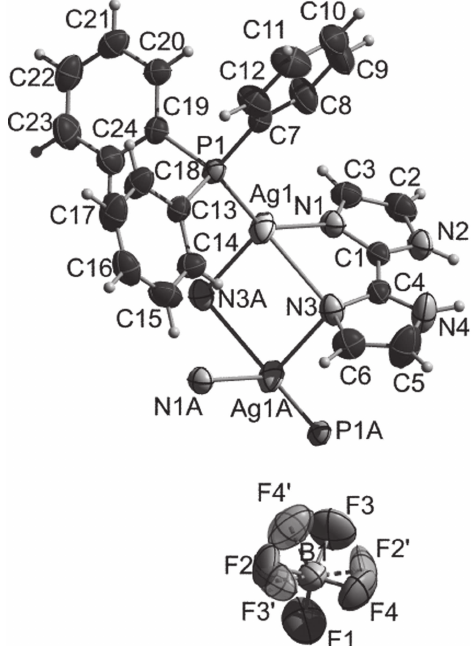
Table 1: Data collection and handling.